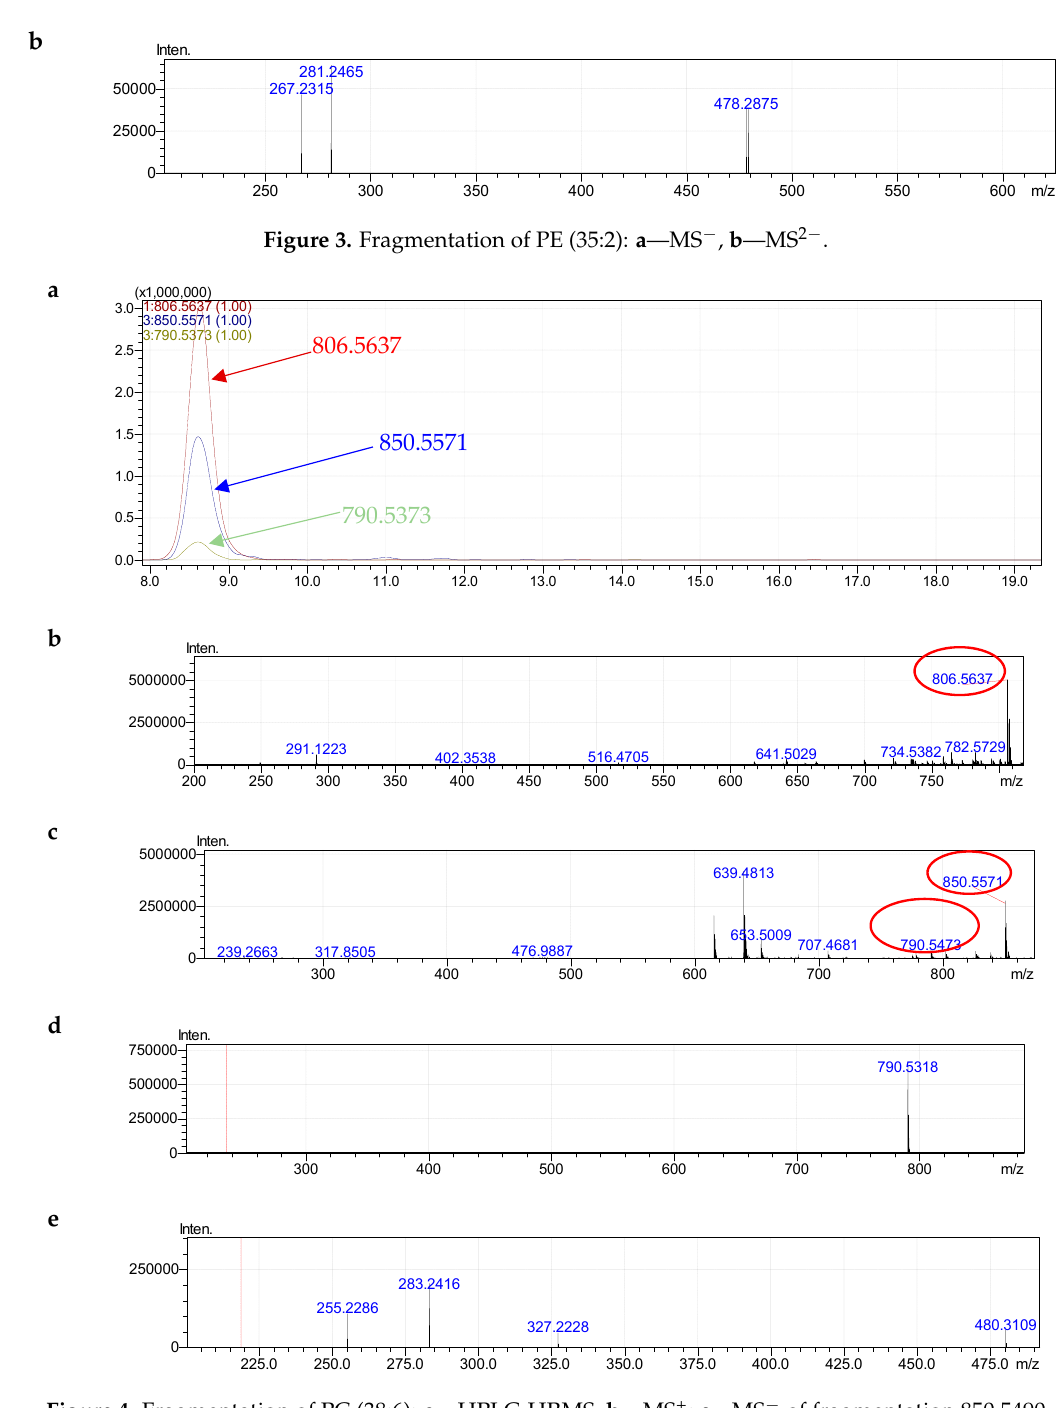
Figure 4. Fragmentation of PC (38:6): a —HPLC-HRMS, b —MS + ; c —MS − of fragmentation 850.5490 and 790.5301; d , e —MS 2 − of fragmentation 850.5490 and 790.5301.